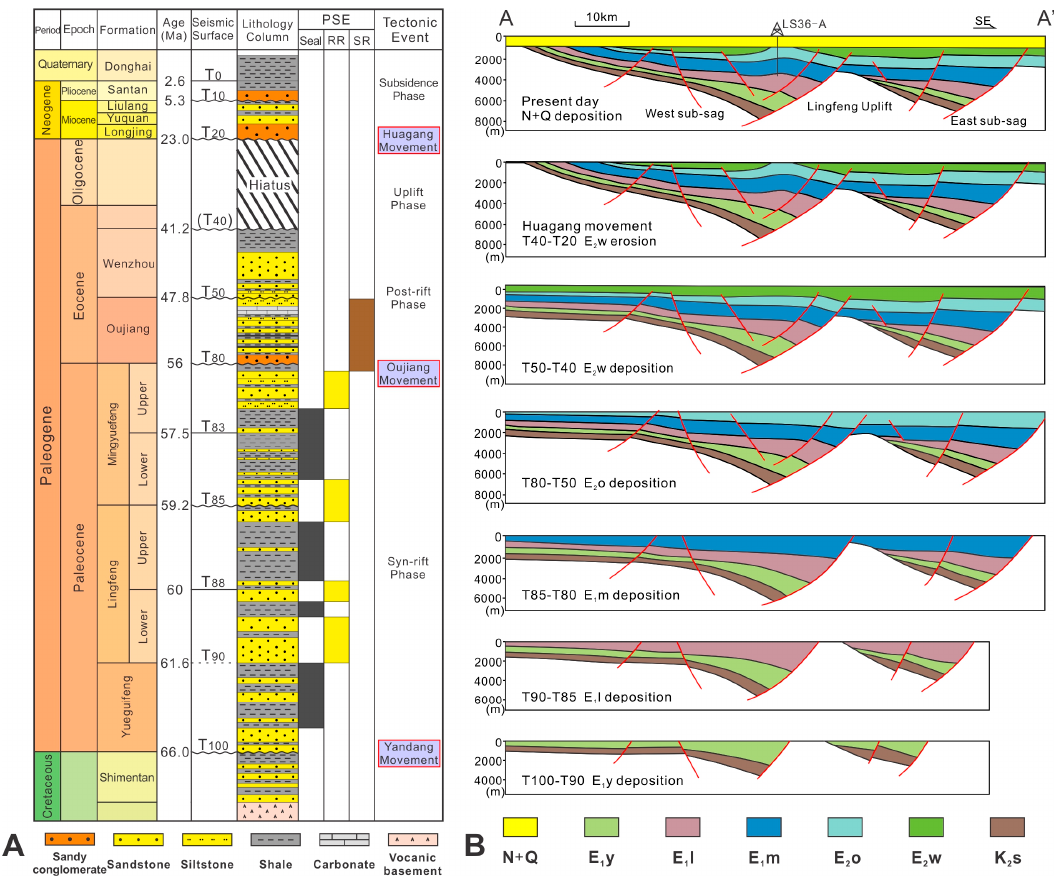
Figure 2 . ( A ) Lithostratigraphy of the Lishui Sag and ( B ) the tectonic evolution in the Lishui Sag. The petroleum system elements (PSE) including seal rocks (Seal), source rocks (SR) and reservoir rocks (RR), as well as the general overview of the geologic and tectonic events are also shown. The wavy line indicates the angular unconformity and the dash line indicates the parallel unconformity. The location of section AA’ is shown in Figure 1B.